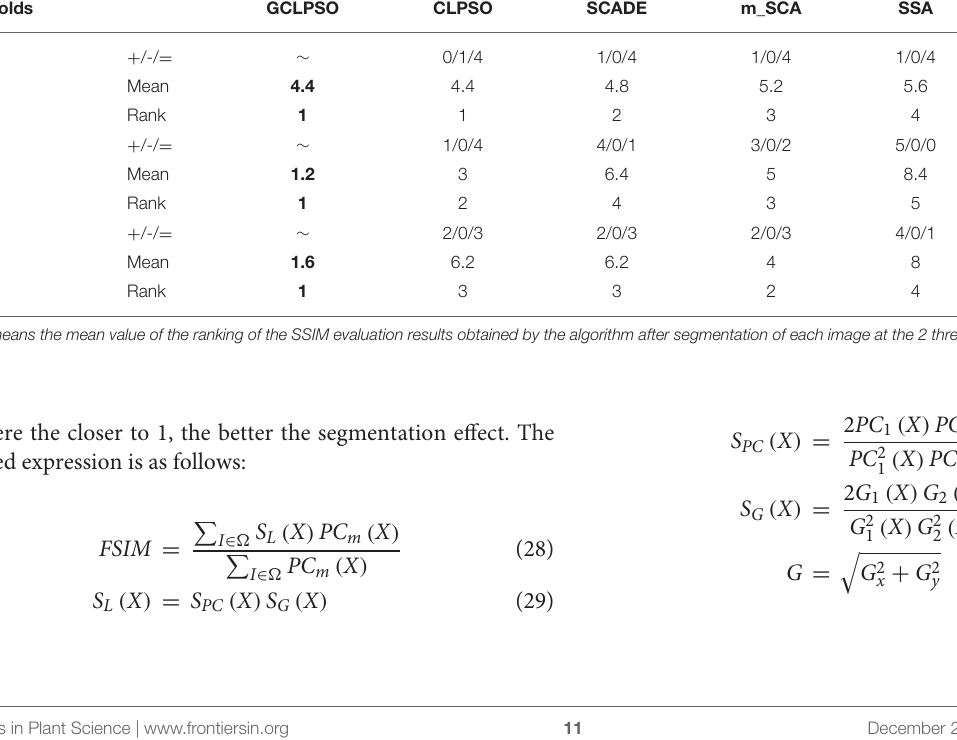
TABLE 10 | Results of the SSIM comparison by the Wilcoxon signed-rank test at each threshold level of maize rust disease.